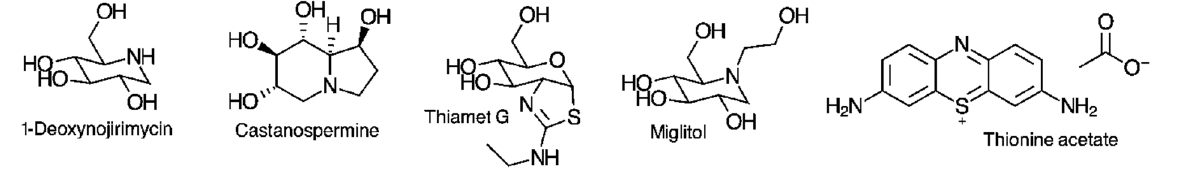
Figure 1. Structures of some reported glycosidase inhibitors and thionine acetate.